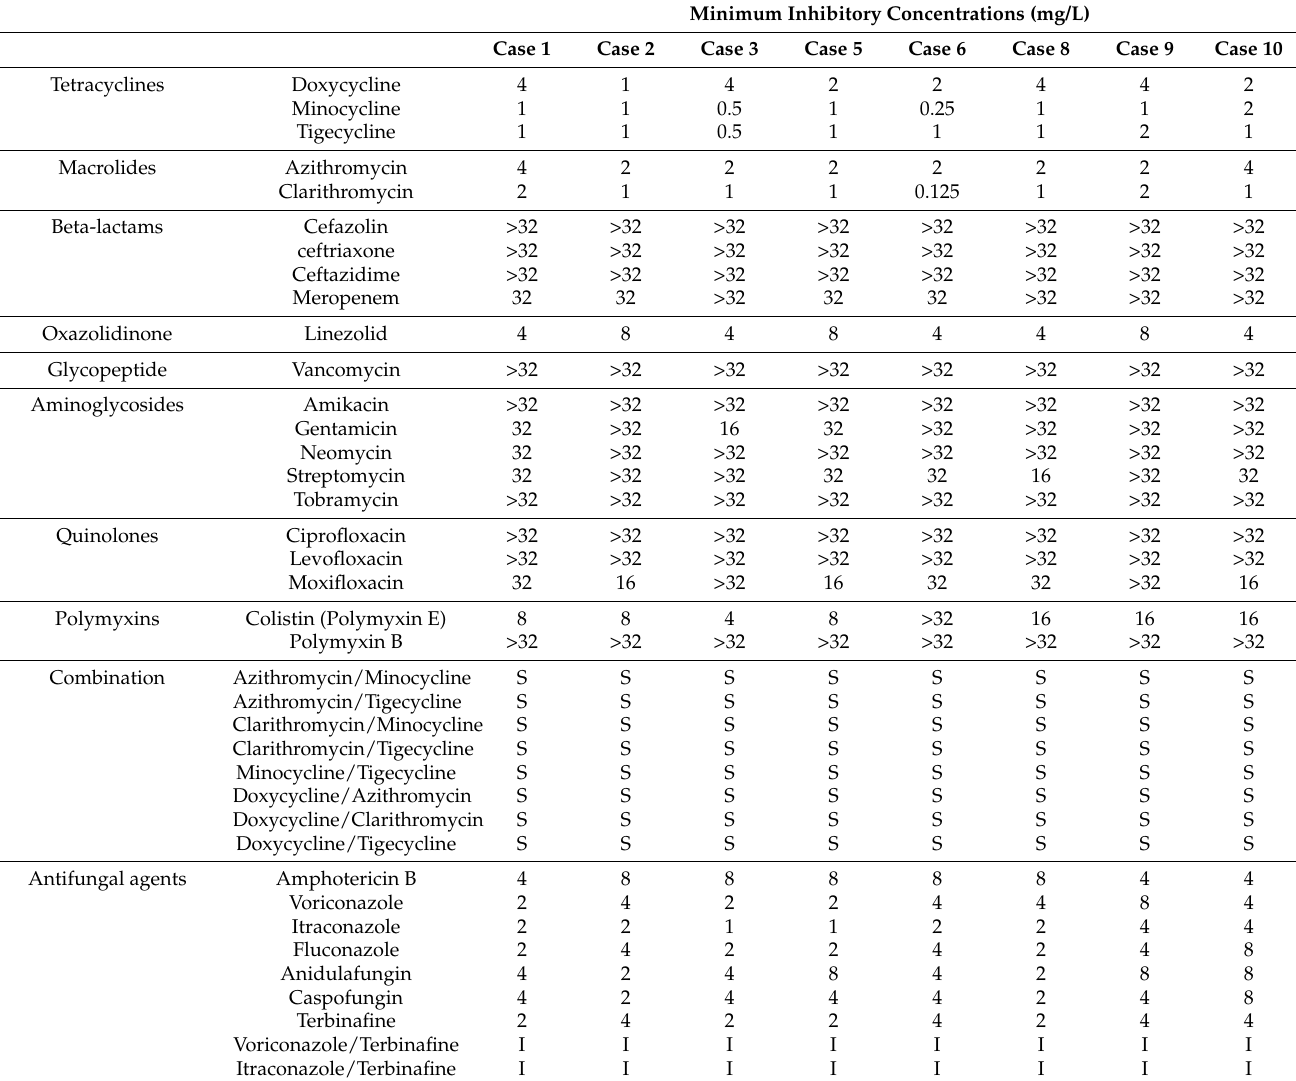
Table 2. In vitro susceptibility results of Pythium insidiosum